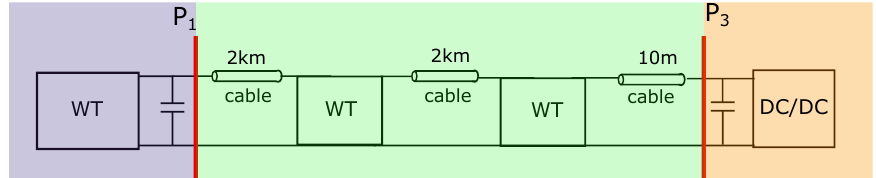
Figure 1. String configuration.